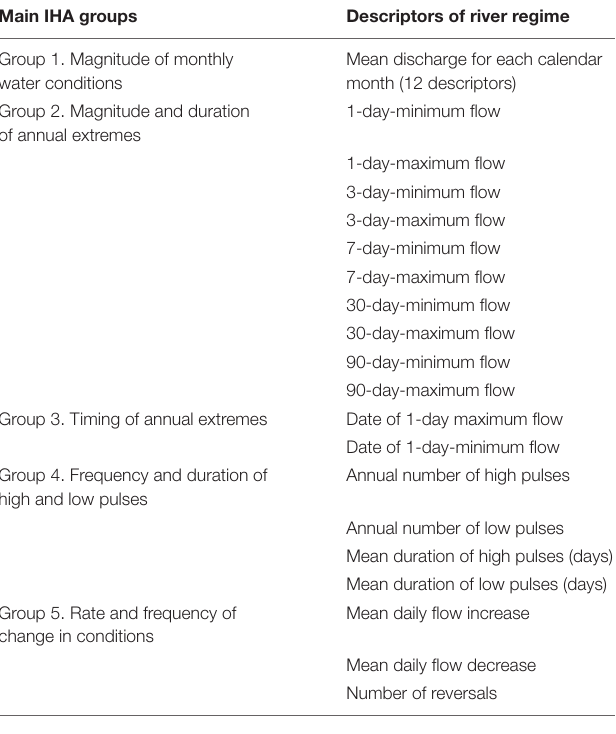
TABLE 2 | Indicators of Hydrologic Alteration (IHA) flow regime descriptors (from Richter et al., 1996). Main IHA